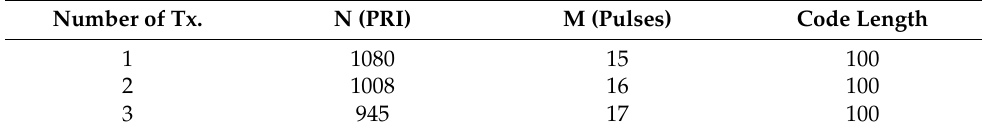
Figure 4. Description of parameters in Table 1. Table 1. Waveform parameters.